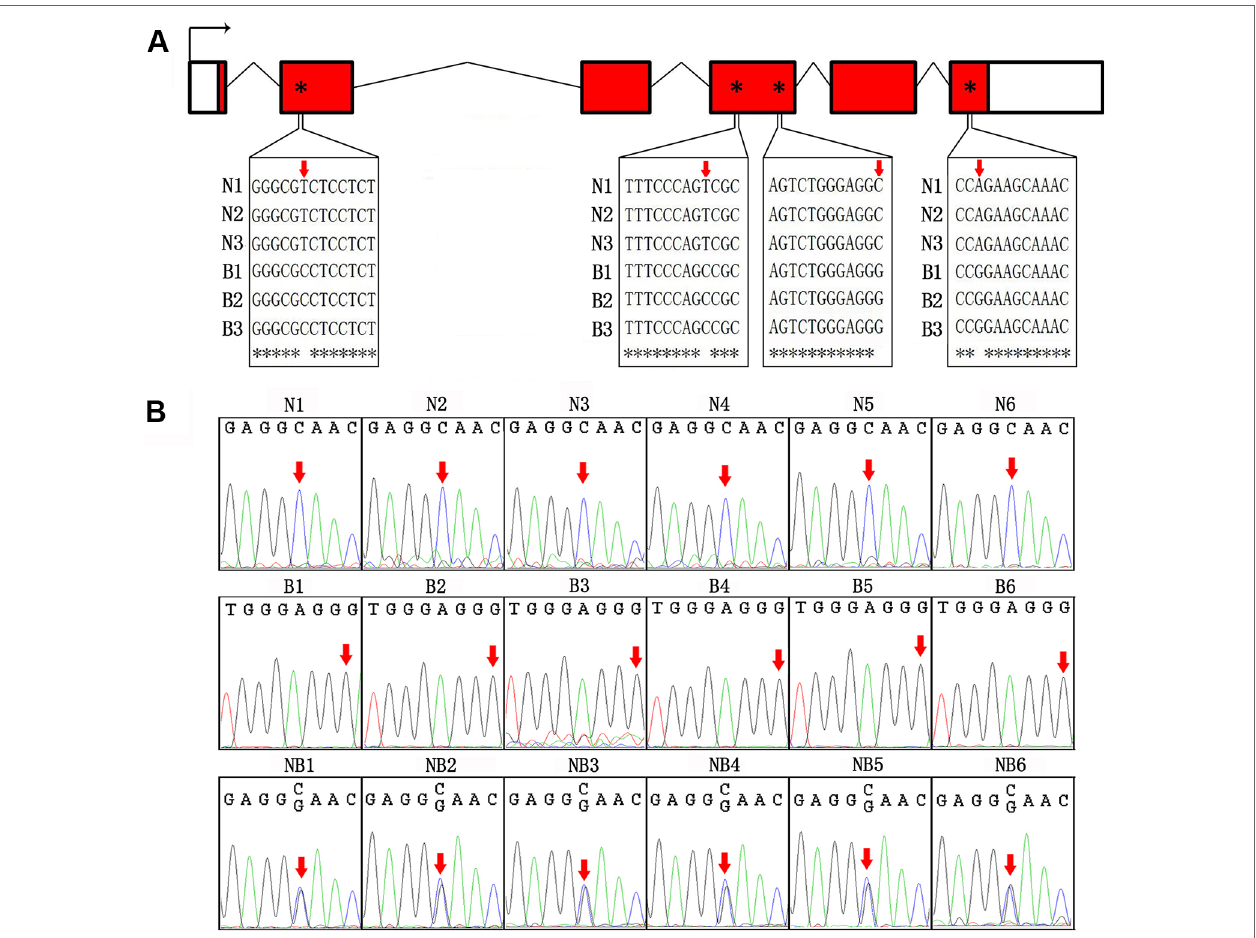
FIGURE 3 | Identification of SNP between Nile tilapia and blue tilapia. (A) Four SNPs were identified from the cDNA sequences of Nile tilapia and blue tilapia by alignment using ClustalW. Bent arrow represents the transcription start site. Empty boxes represent the 5 ′ and 3 ′ UTRs. Red boxes represent exons. Broken lines indicate introns. Red arrows and asterisks indicate the SNP sites. (B) Validation of the third SNP site (nucleotide 501) from the DNA sequences by Sanger sequencing in Nile tilapia (N1–N6), blue tilapia (B1–B6), and hybrid (NB1–NB6). Red arrows indicate the SNP